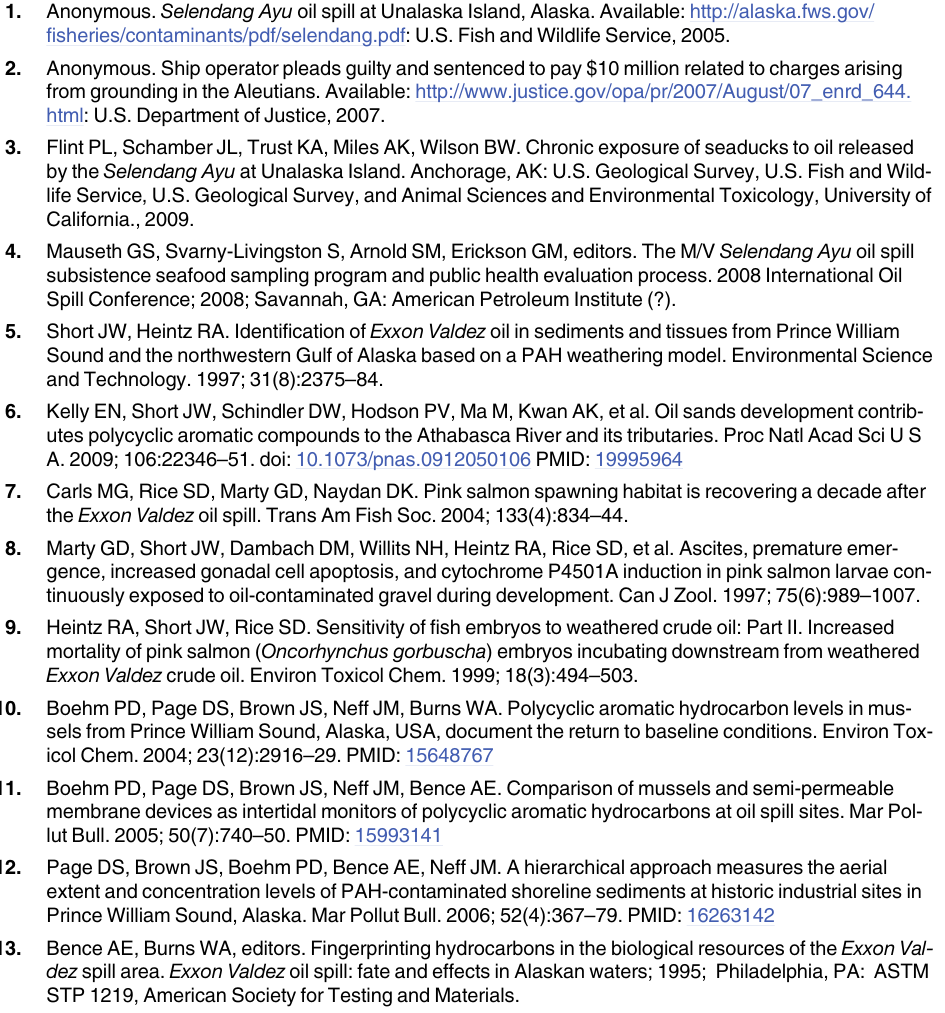
), intermediate fuel oil H